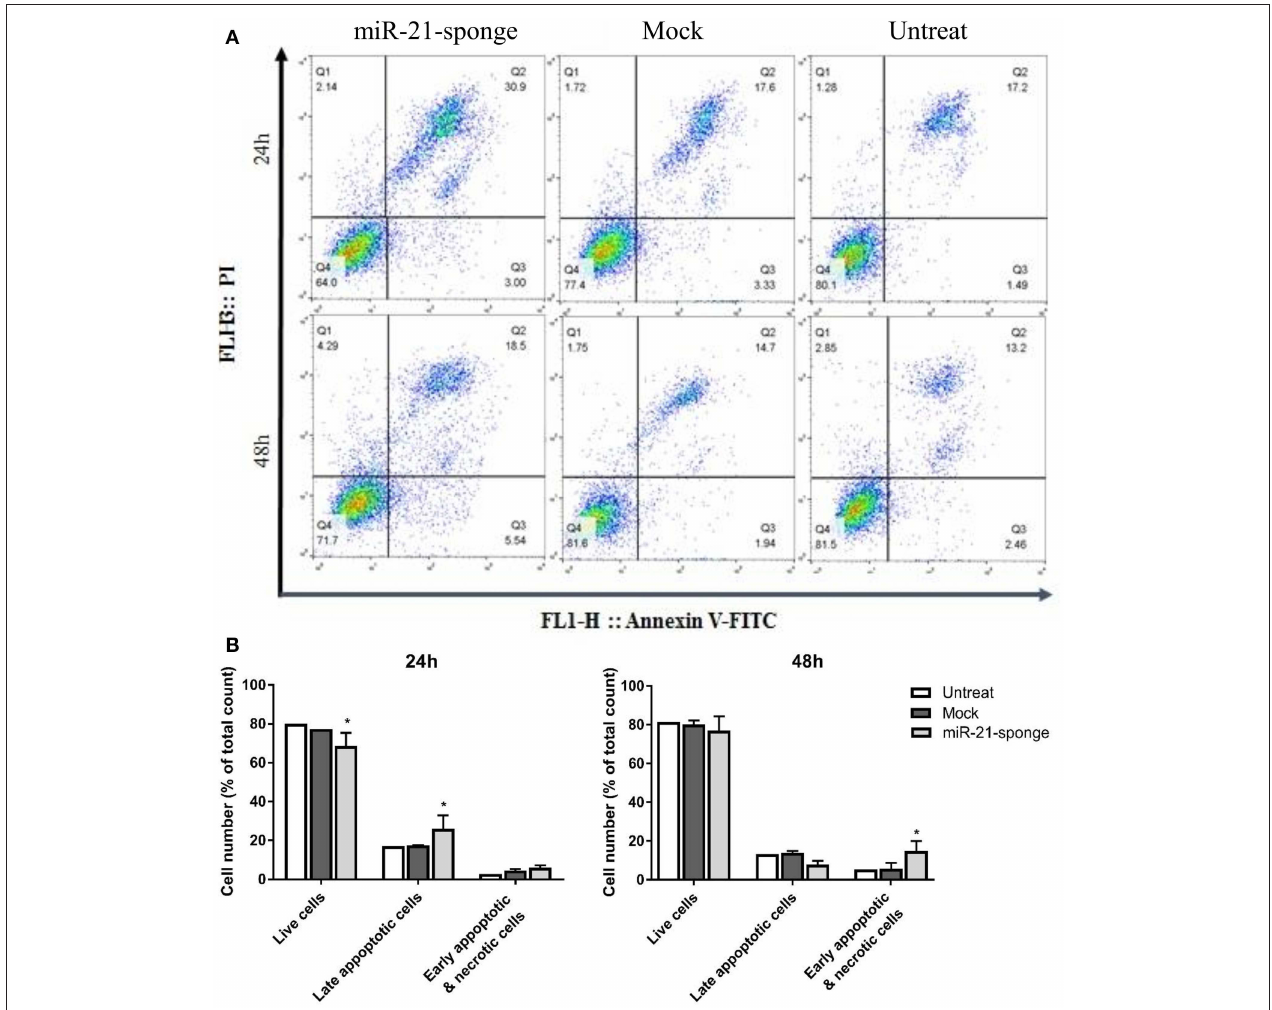
FIGURE 6 | The apoptosis rate in U87-MG cells exposed to the engineered exosomes. (A) A typical quadrant analysis of Annexin V-FITC/PI flow cytometry of U87-MG cells after 24 and 48h of treatment with miR-21-sponge, compared to the exosomes extracted from the mock-Tracer vector expressing and untransfected HEK293T cells. The proportion (%) of cell numbers is shown for each quadrant. The proportion of viable cells was shown in Q3 quadrant (FITC − /PI − ), early apoptotic cells shown in Q4 quadrant (FITC + /PI − ), late apoptotic cells shown in Q2 quadrant (FITC + /PI + ), and necrotic cells shown in Q1 quadrant (FITC − /PI + ). (B) An increased late apoptotic cell numbers and an decreased alive cell numbers in U87-MG cells treated with miR-21-sponge containing exosomes was evident after 24h ( P < 0.05). At 48h, there was no significant difference in the late apoptotic and alive cell numbers, however, a significant increase in the early apoptotic and necrotic cell numbers was observed ( P < 0.05). * P < 0.05, which is represented by some statistical software like Graph